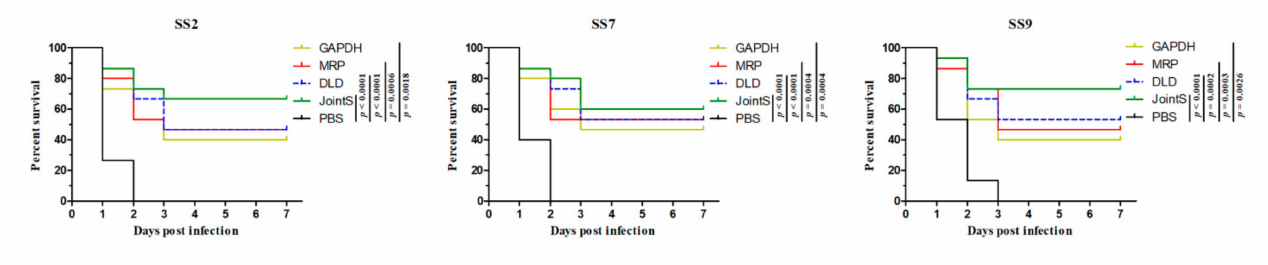
Figure 1. Kaplan–Meier survival curves of vaccinated zebrafish infected with different serotypes of S. suis . Seven days after booster immunization, SS2, SS7, or SS9 were injected into the abdominal cavities of the zebrafish. PBS-vaccinated zebrafish infected with S. suis served as PBS control groups. Survival rate was analyzed by a log-rank (Mantel-Cox)